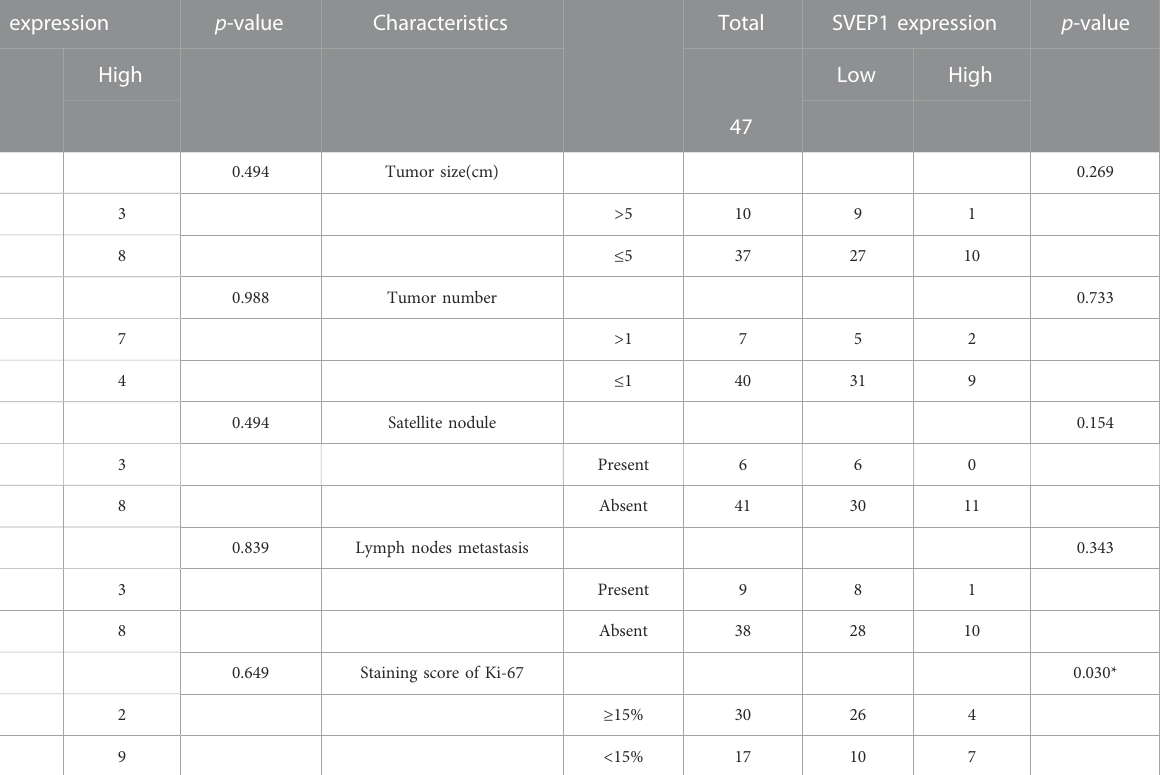
TABLE 2 Relationship between clinicopathological characteristics and SVEP1 expression in 47 ICC